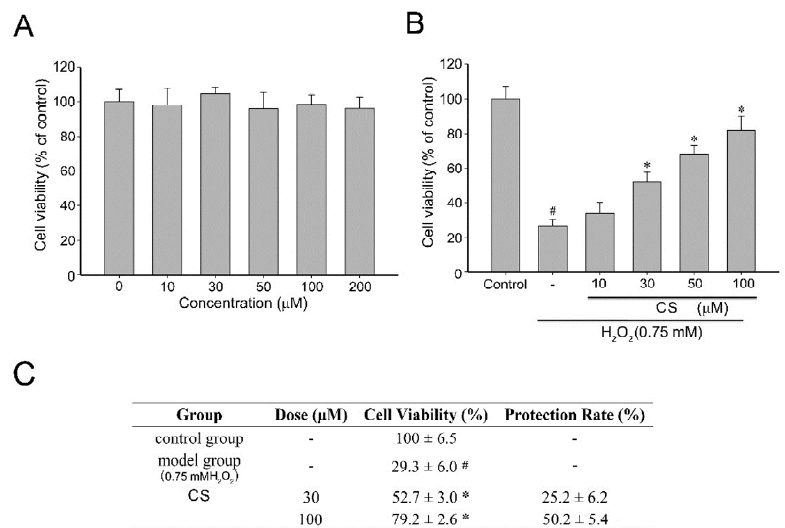
Figure 3. Cytotoxicity and cytoprotective activity of costunolide (CS). ( A ) PC12 cells were pretreated with various concentrations of CS for 4 h; ( B ) Cell viability of PC12 cells pretreated with CS (10, 30, 50 and 100 µM) 1 h before exposure to H 2 O 2 (0.75 mM) 4 h was measured by the MTT assay. Data are presented as mean ± SD ( n = 3) and ( C ) The protection rates of CS are shown. Values with the same superscript letters are not significantly different from each other. # p < 0.01 compared with the control group; * p < 0.05, compared with the model group.